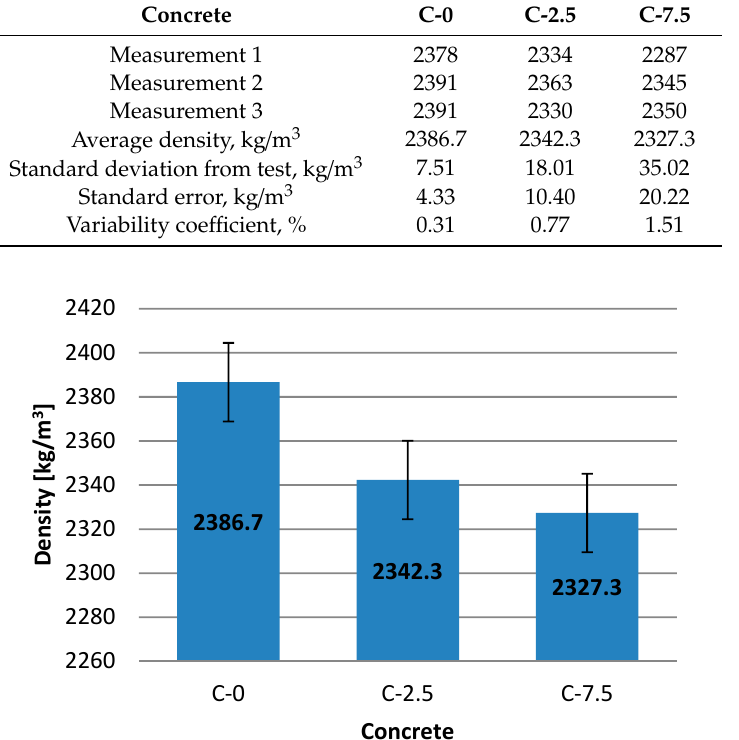
Table 8. Apparent density of concrete.